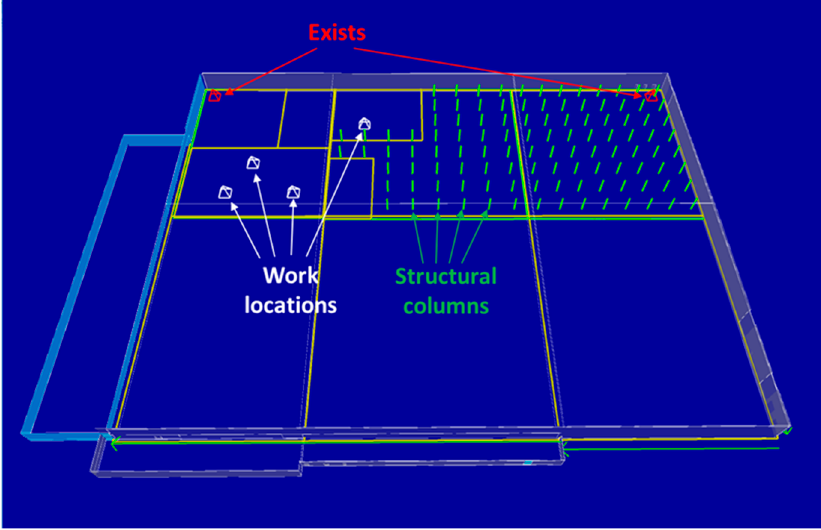
Figure 11. Site condition of scenario 1 reflected in the prototype system.